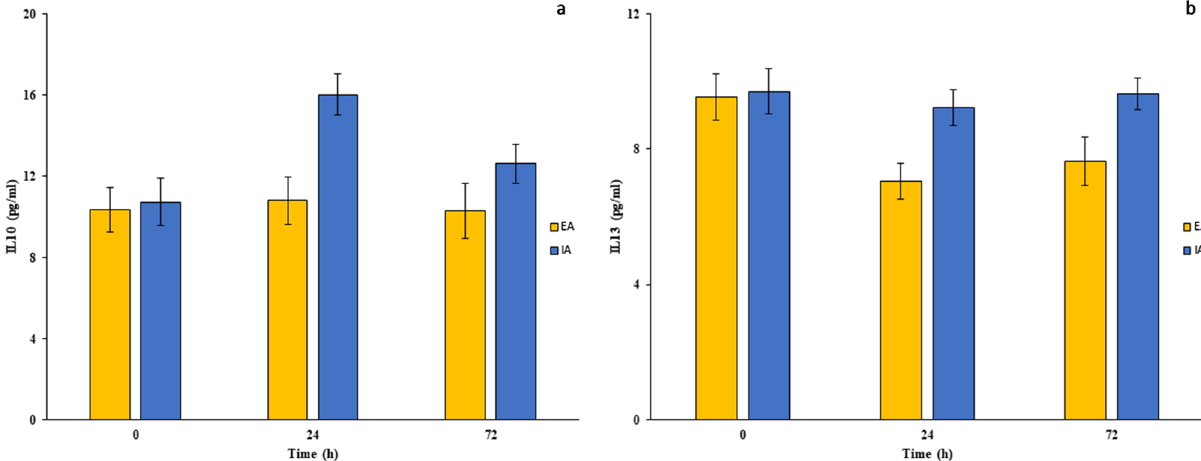
Figure 2. Anti-inflammatory response after EA and IA surgeries in colon cancer patients. Serum IL-10 ( a ) and IL-13 ( b ) levels were evaluated in colon cancer patients undergoing EA or IA anastomosis in laparoscopic right hemicolectomy surgeries 0, 24 and 72 h postsurgery. Results are shown as means ± SD. Statistical analysis was performed using Kurskal Wallis test and Bonferroni post-test correction.